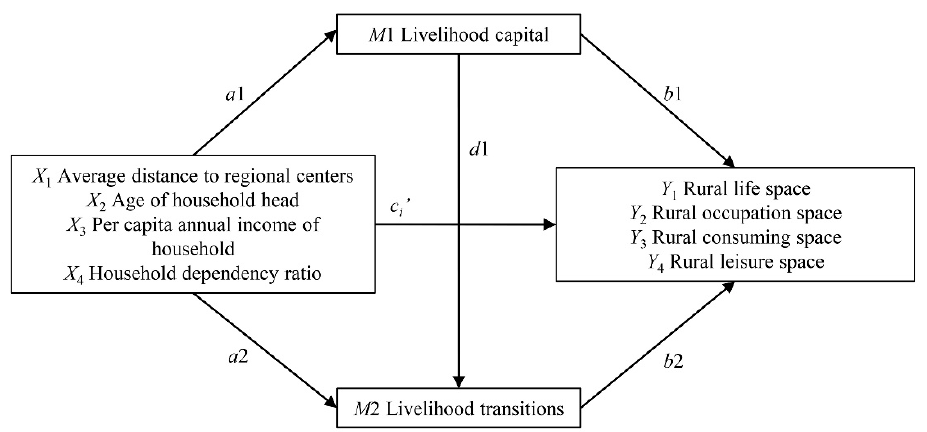
Figure 2. Multiple mediation model for the relation between rural households and accessibility of rural life space. rural life